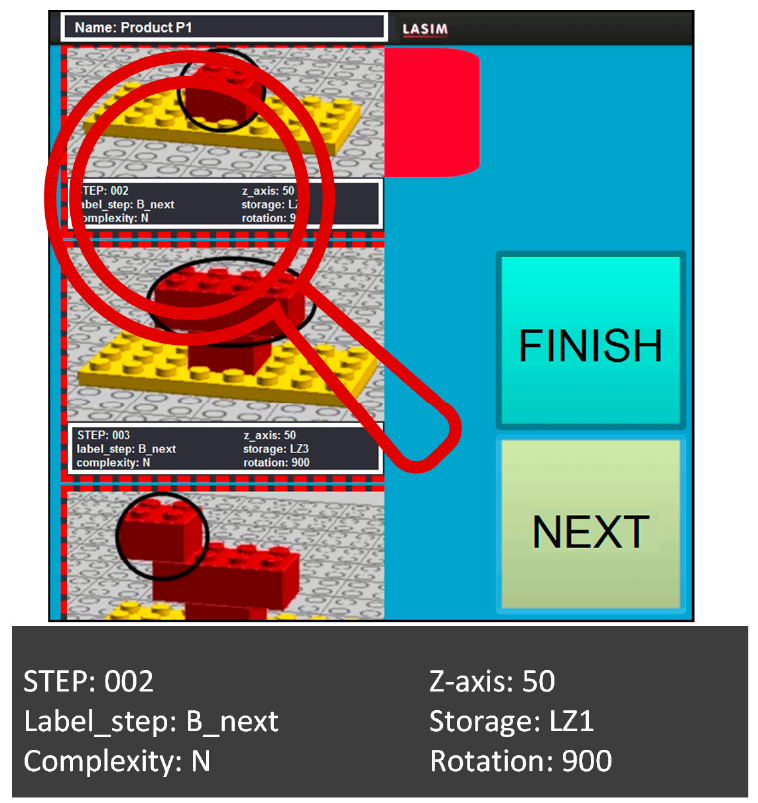
Figure 5. Labels that are written for each step of the product